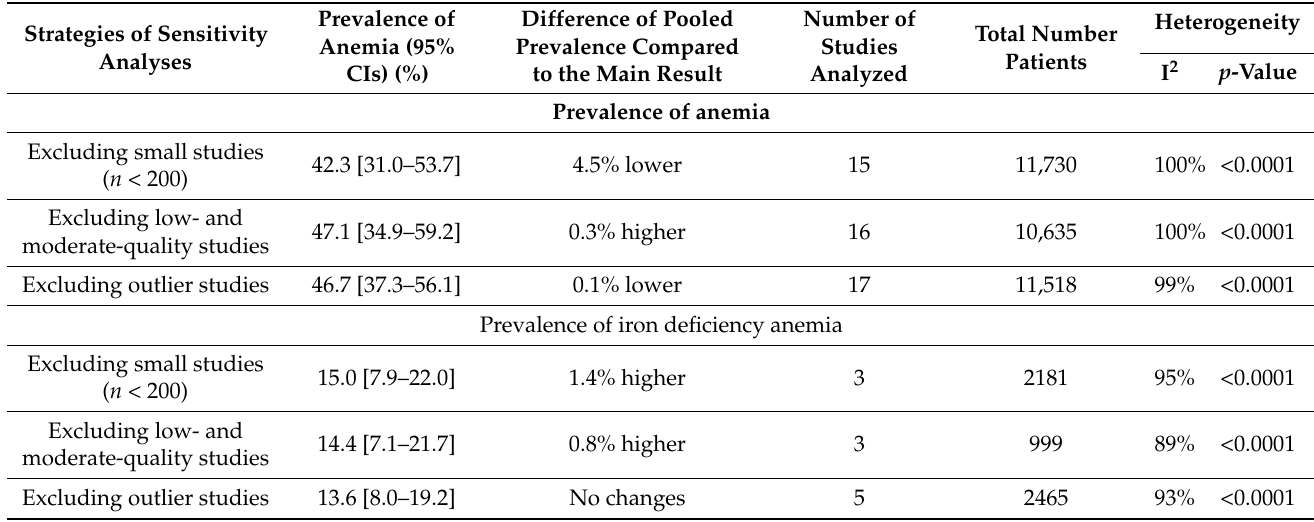
Table 3. Sensitivity